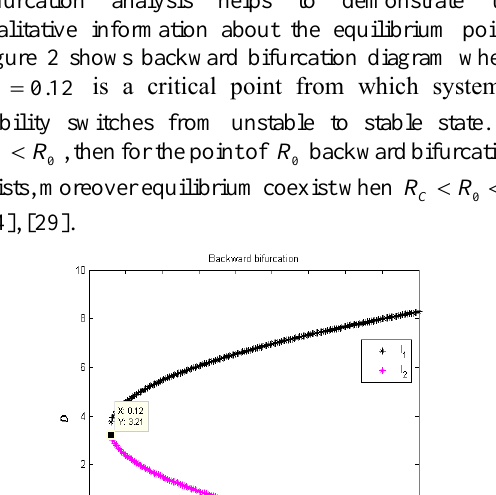
Figure 5. Change in objective function with time Figure 5 gives change in objective function under influence of both the controls combine and individually which gives combine and individual effect of both the controls on malaria-dengue model. It is clearly visible that combine effect of controls gives more fruitful effect on the model compare to an individual effect.